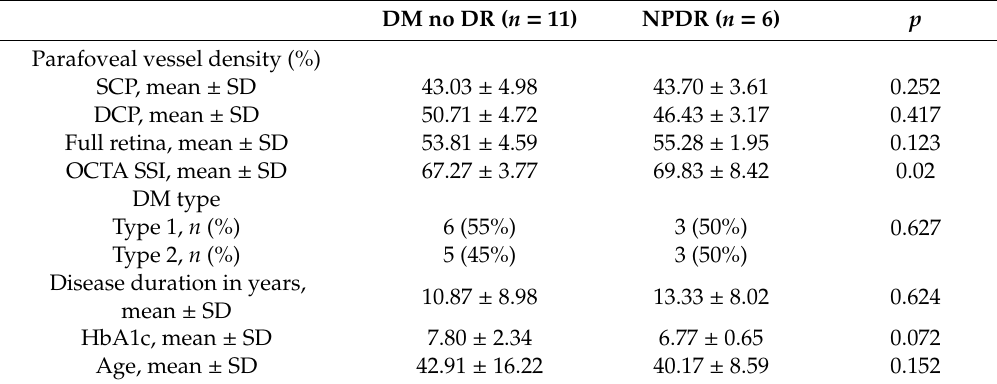
Table 8. Demographics and clinical measurements comparing low-flow diabetes without retinopathy and high-flow non-proliferative diabetic retinopathy